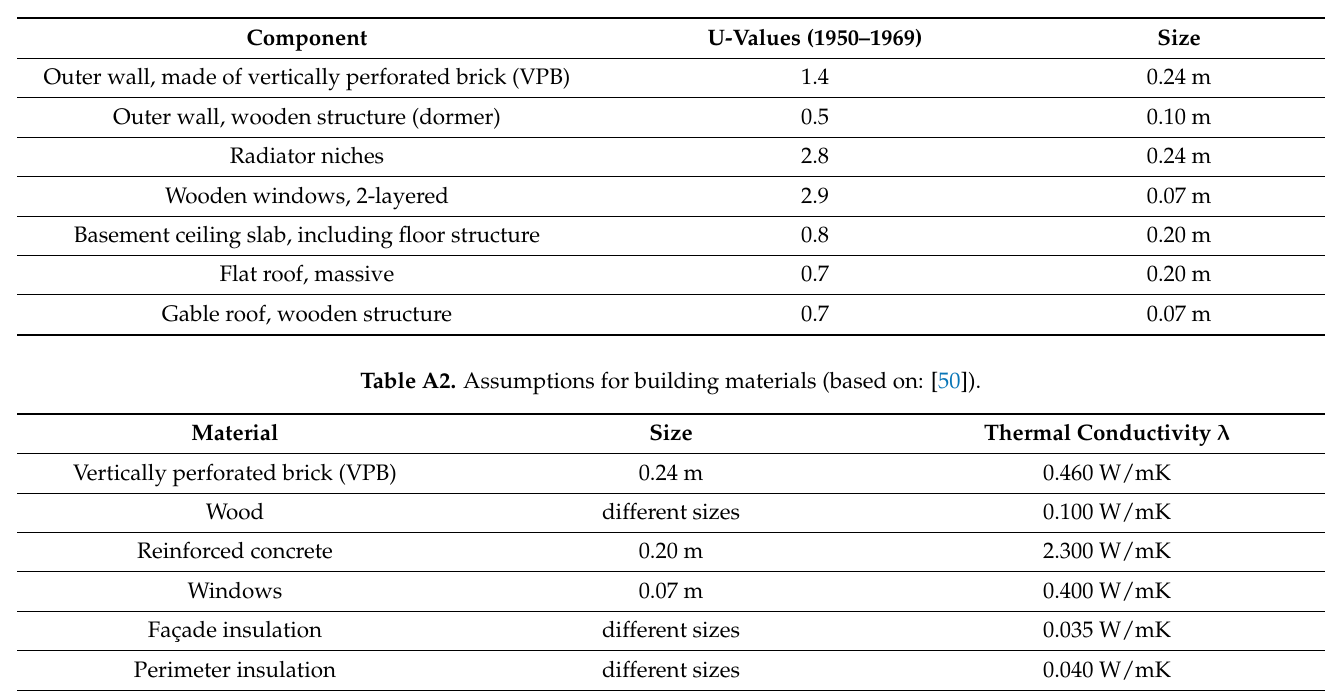
Table A1. Typical U-values for German buildings constructed in the 1950s–1960s (based on: BMWi and BMU, 2015) [49].